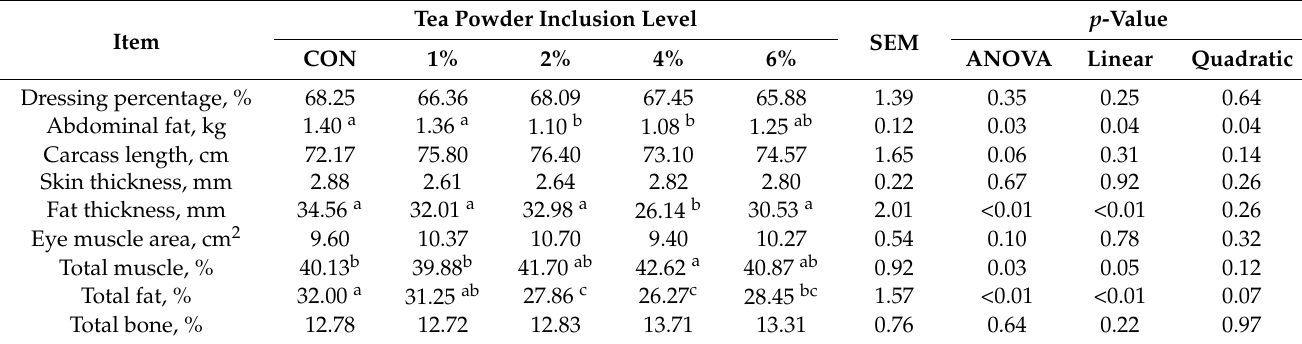
Table 5. Effects of dietary supplements with tea powder on carcass traits of the pigs.